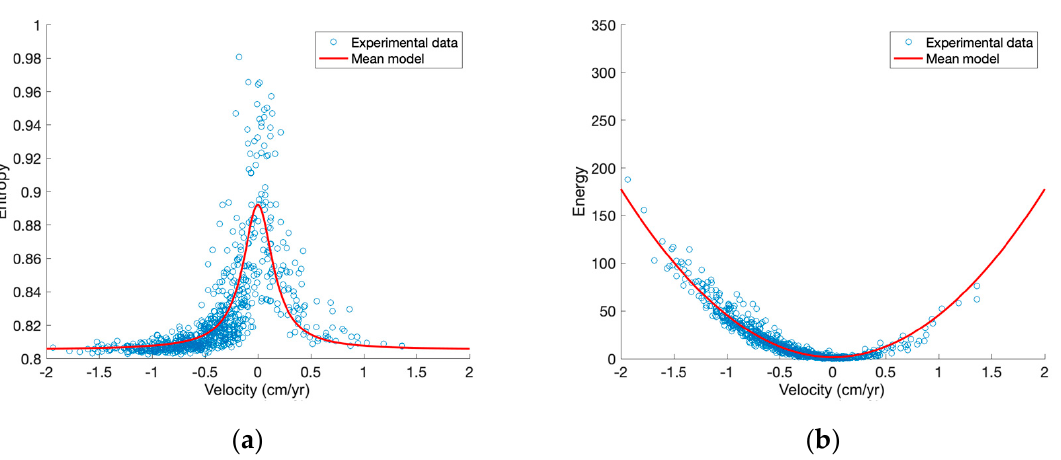
Figure 8. Correlation between LOS velocity and entropy–energy dispersion in the period from 2017 to 2019 for a building complex near San Giovanni station: ( a ) Entropy–velocity dispersion; ( b ) En- ergy–velocity dispersion.